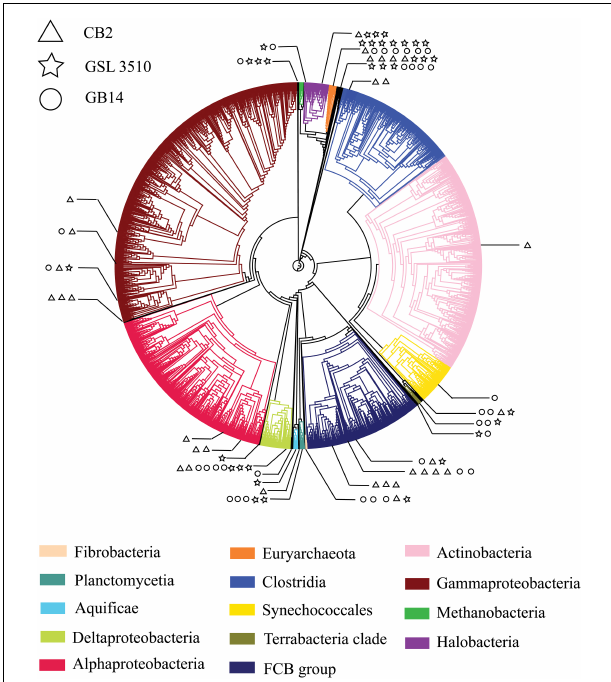
FIGURE 4 | A phylogenetic tree of Great Salt Lake metagenome-assembled genomes (MAGs). The MAGs with contamination ( > 5%) assessed by CheckM v1.0.7 (Parks et al., 2015) were placed in the reference phylogenetic tree inferred with 43 conserved marker genes using CheckM v1.0.7 (Parks et al., 2015). The phylogenetic tree was annotated with CLC Genomics Workbench v.12 (CLC Bio, Denmark). The branch of the reference tree represents ‘Class,’ taxonomy. Each ‘Class’ is denoted with individual color. The branches with Great Salt Lake MAGs are expanded to show their taxonomic position on the phylogenetic tree. The Great Salt Lake MAGs from three sites on the Lake are distinguished with different